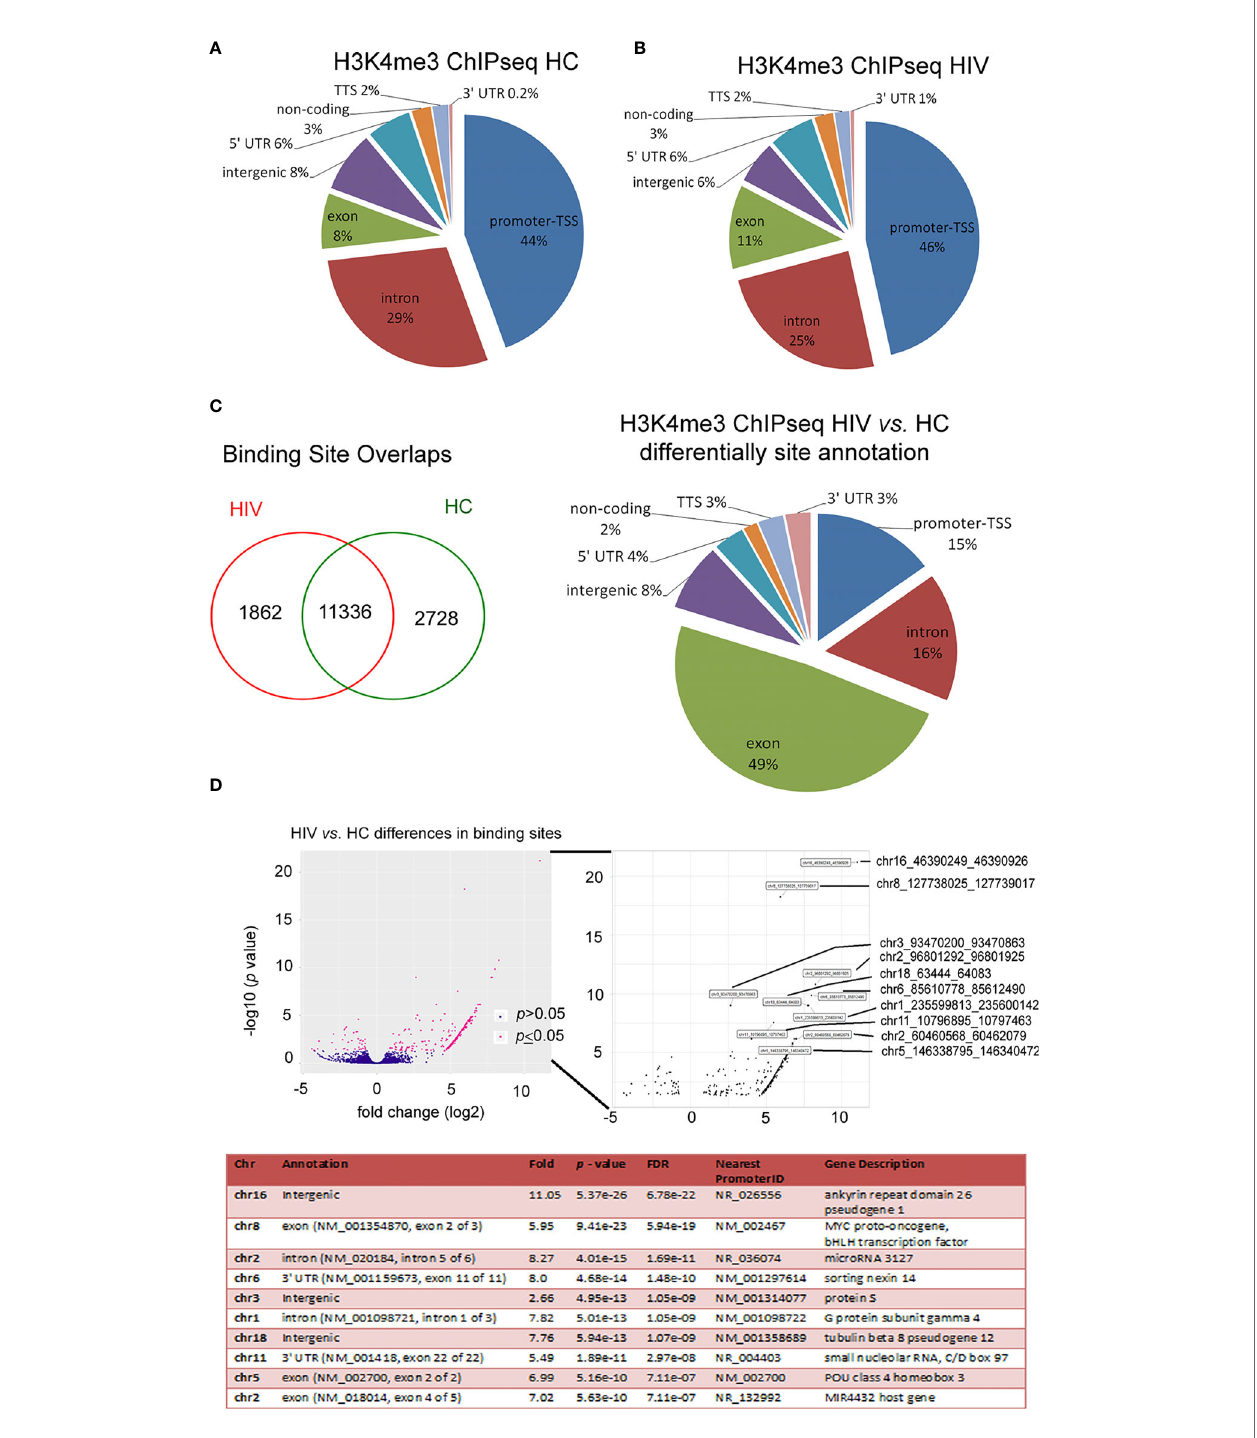
FIGURE 2 | HIV neutrophil H3K4me3-marked histones are characterized by large fl uctuations within DNA annotation. (A) Pie chart analysis of separate samples within H3K4me3 in HIV and HCs showed only minor differences in DNA annotation of genomic regions. (B) Binding sites overlap analysis revealed 1,862 DNA sequences associated with H3K4me3 that speci fi c characterize HIV patients. (C) Compression of HIV vs. HCs demonstrated the most important changes in exon, intron and promoter TSS genomic features. (D) Analysis of statistic differences in protein binding to the H3K4me3 region revealed that most of the binding sites in HIV neutrophils are upregulated. Left and bottom panel show statically signi fi cant differences in binding sites as enlarged region. Low panel displays ten peaks with highest statistically signi fi cant differences and lowest FDR. More details and all peaks with statistically signi fi cant differences are presented in the